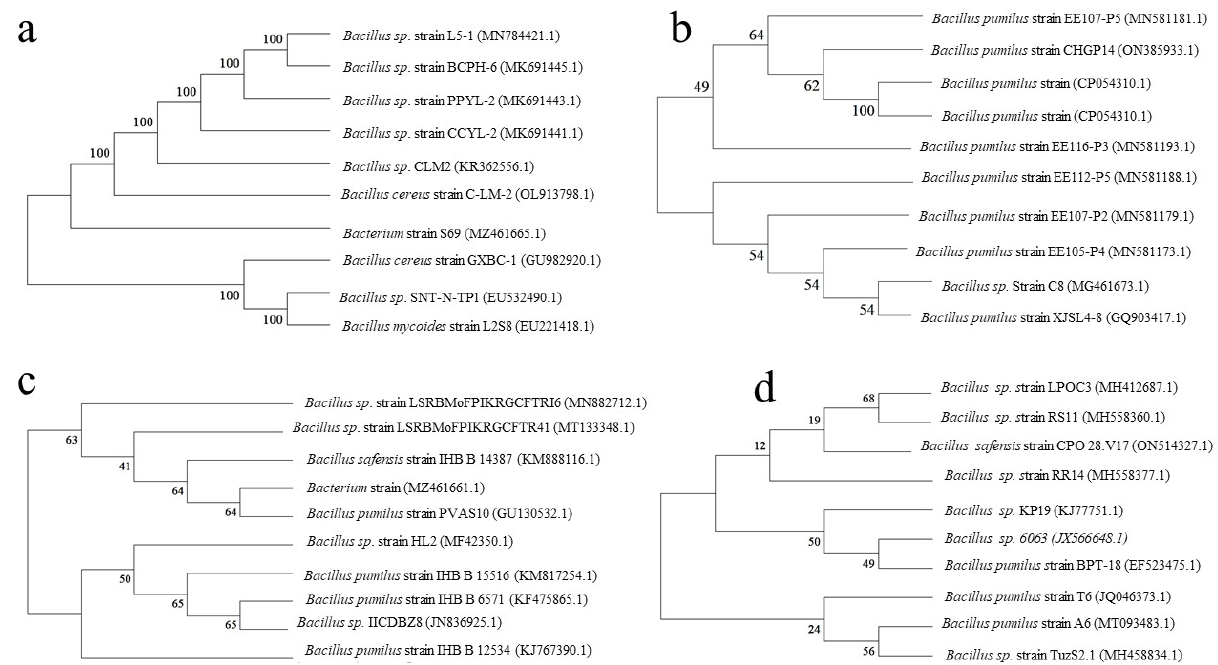
Figure 4. Neighbour-joining phylogenetic tree of bacterial isolates and their closely matching hom-